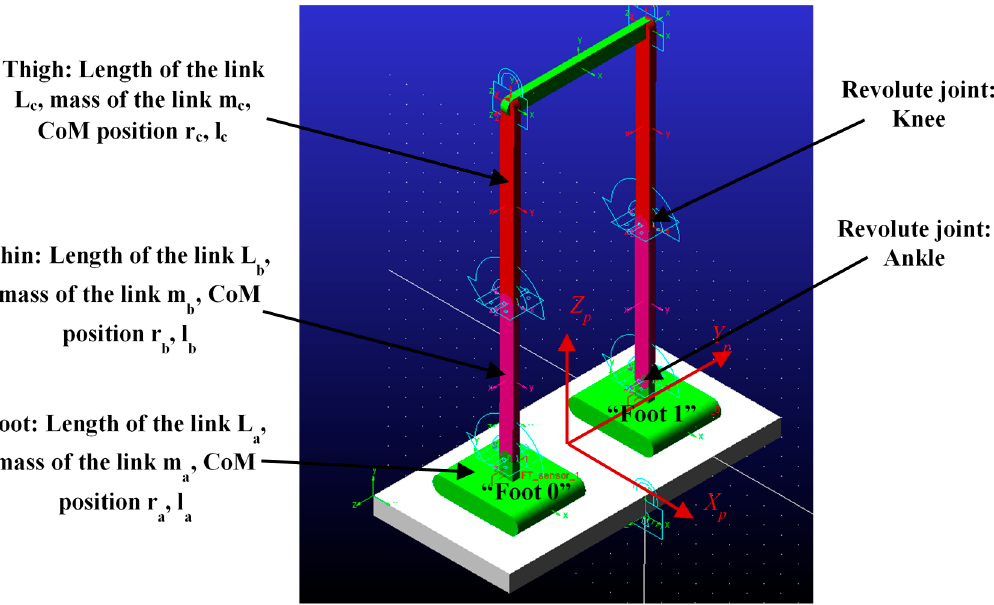
Figure 6. Example for implementing the formula. Table 1. Characteristics of the robot